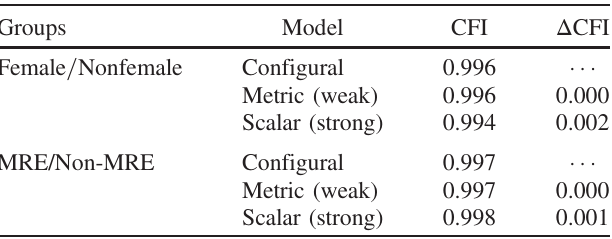
TABLE III. CFI and Δ CFI for Study 1 invariance tests.